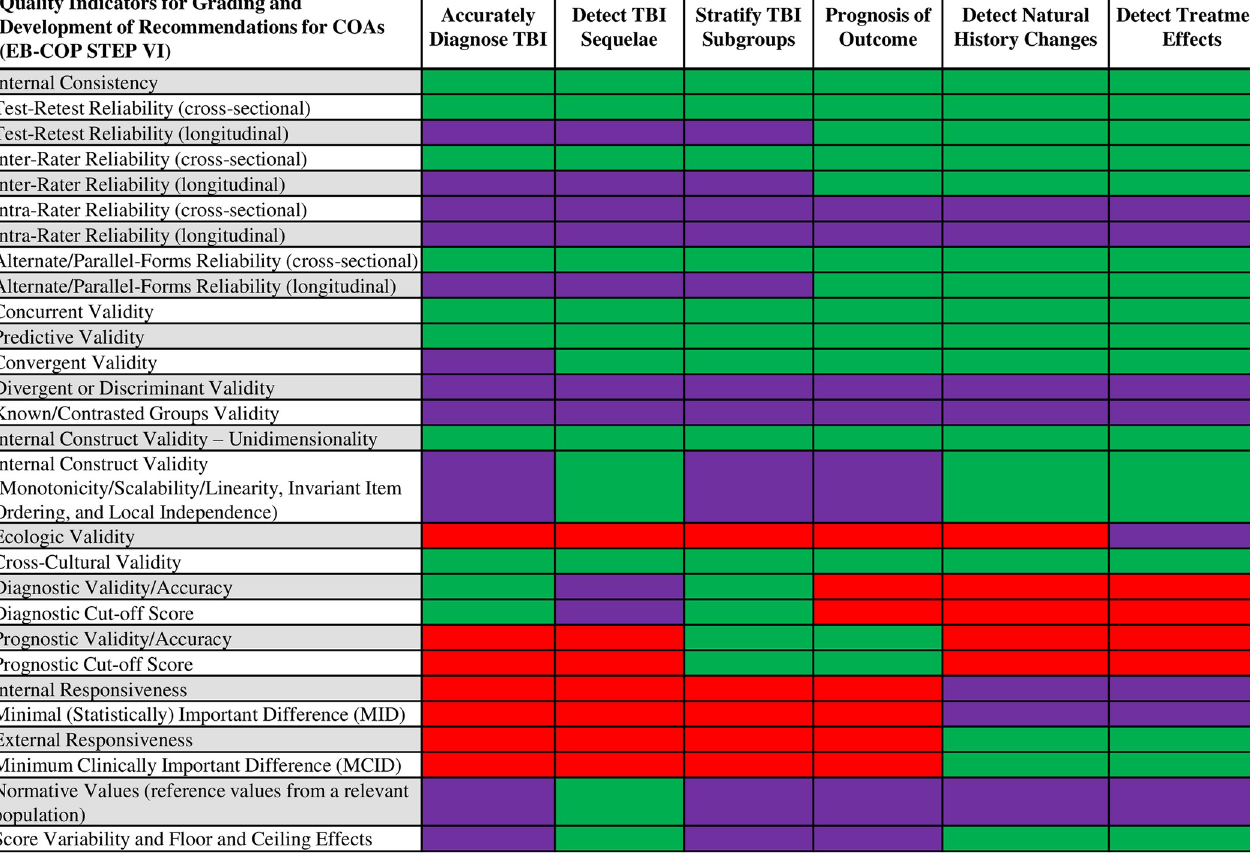
Fig 2. COA quality indicators organized by purpose of use and level of obligation. QIs were selected for each of the six COA applications. Mandatory QIs are shaded green, non-mandatory QIs (i.e., should be assessed if investigated) are shaded purple and QIs that are not relevant to a specific purpose are shaded red.